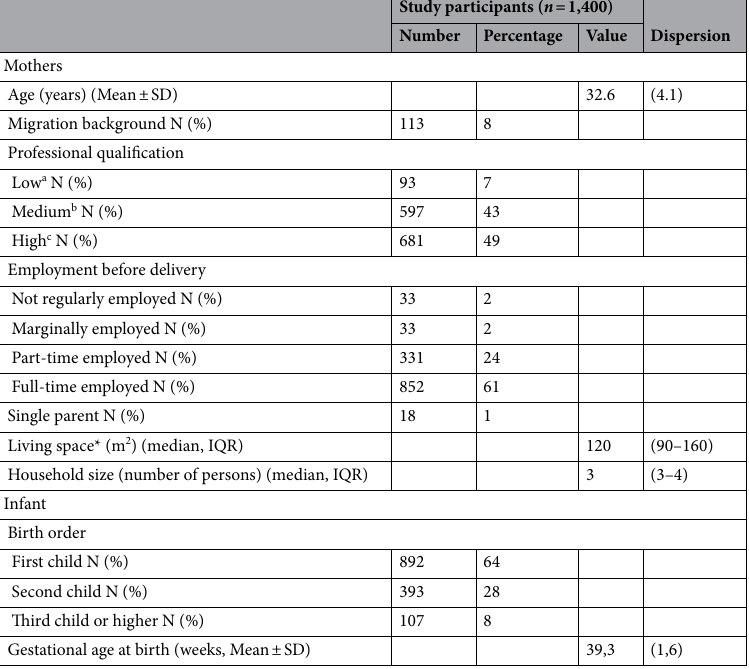
Study participants ( n =